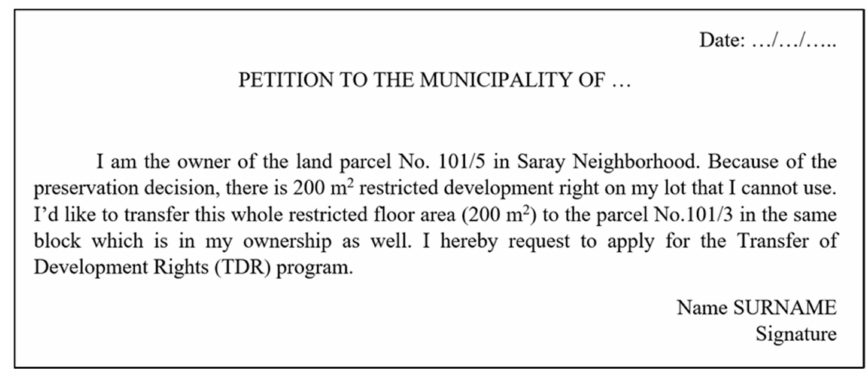
Figure 11. Petition of landowner to municipality for transfer of development